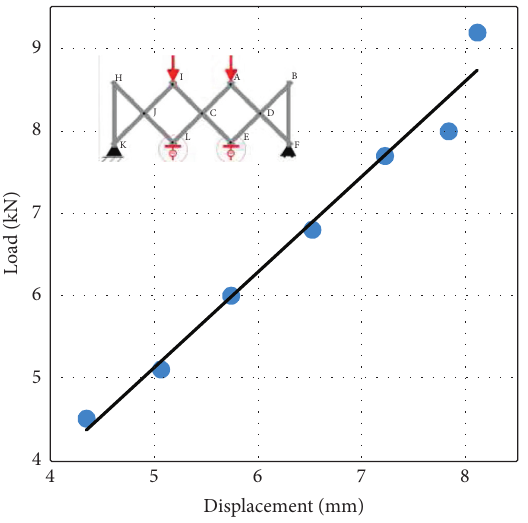
Figure 12: Load-displacement curves of the cable-free